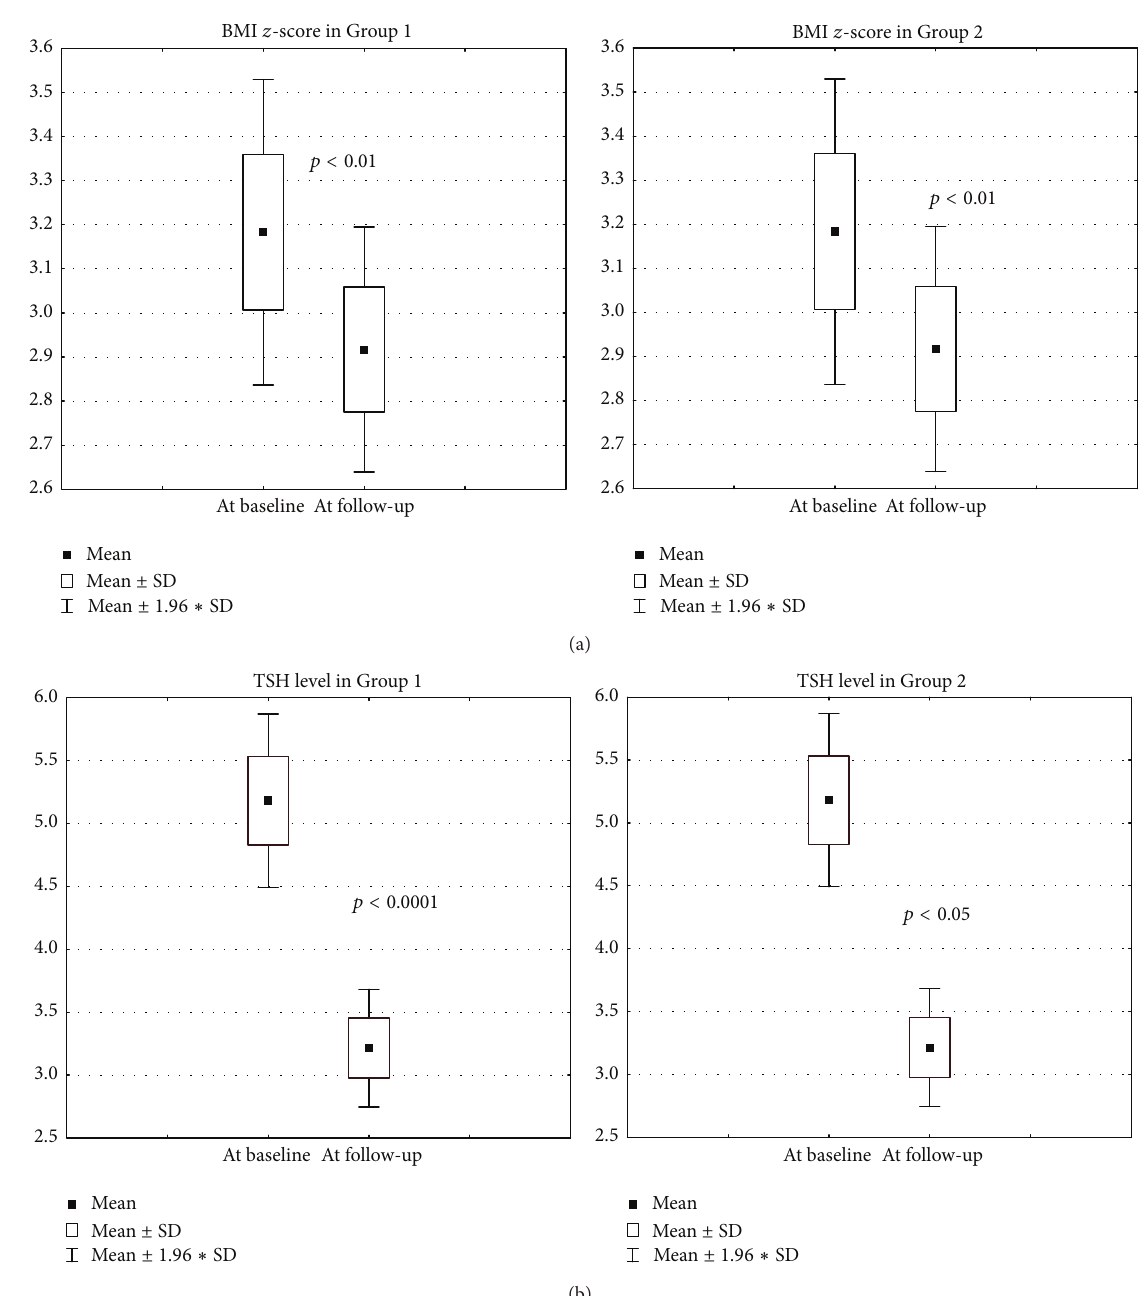
Figure 2: Change of BMI 𝑧 -score at the follow-up visit in both groups. (b) Change of TSH level at the follow-up visit in both groups.